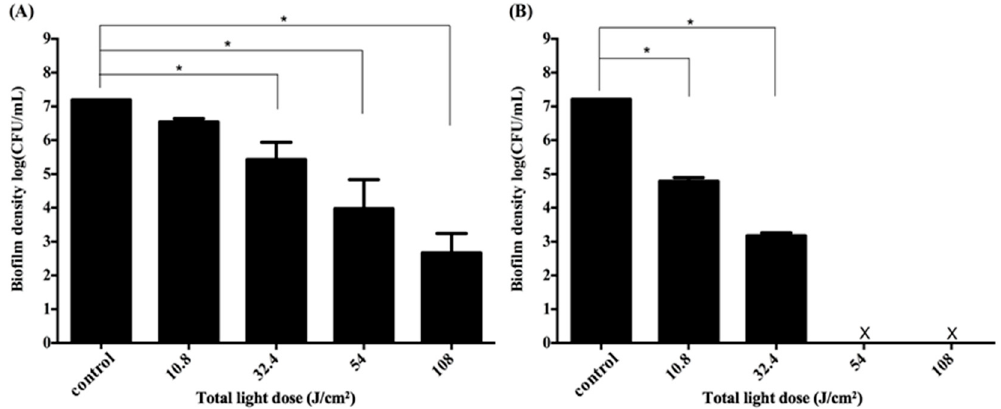
Figure 4. Cell survival fraction of S. aureus biofilm cultured in a 3D gingival model after incubation with F-2 formulas for 0.5 h and subjected to various doses of red-light illumination from four sides. After PDI, S. aureus biofilm was maintained in F-2 for 0.5 h ( A ) and 2 h ( B ) followed by plate count. Each value is the mean of three independent experiments ± standard deviation. * p < 0.05.